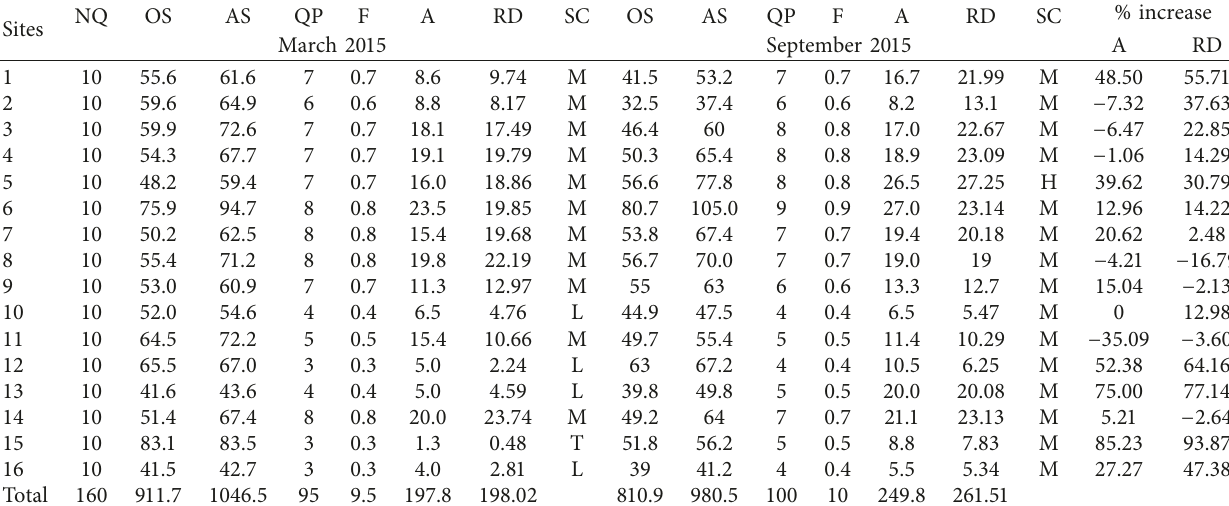
Figure 3: The number of habitats infested with parthenium weed at different sites of Kuala Muda. A � wasteland, B � cattle farm area, C � damping place, D � roadside, E � bank of river, F � farmlands or plantations, and G � residential area and temples/mosques. Small vertical lines above the bars indicate the standard error of Table 2: Total number of quadrats used (NQ), other species/quadrats (OS), number of all species/quadrats (AS), number of quadrats with parthenium (QP), frequency of parthenium distribution (F), parthenium weed abundance (A), relative density (RD) (%), and symbol for severity class (SC) at Kuala Muda in March and September 2015.